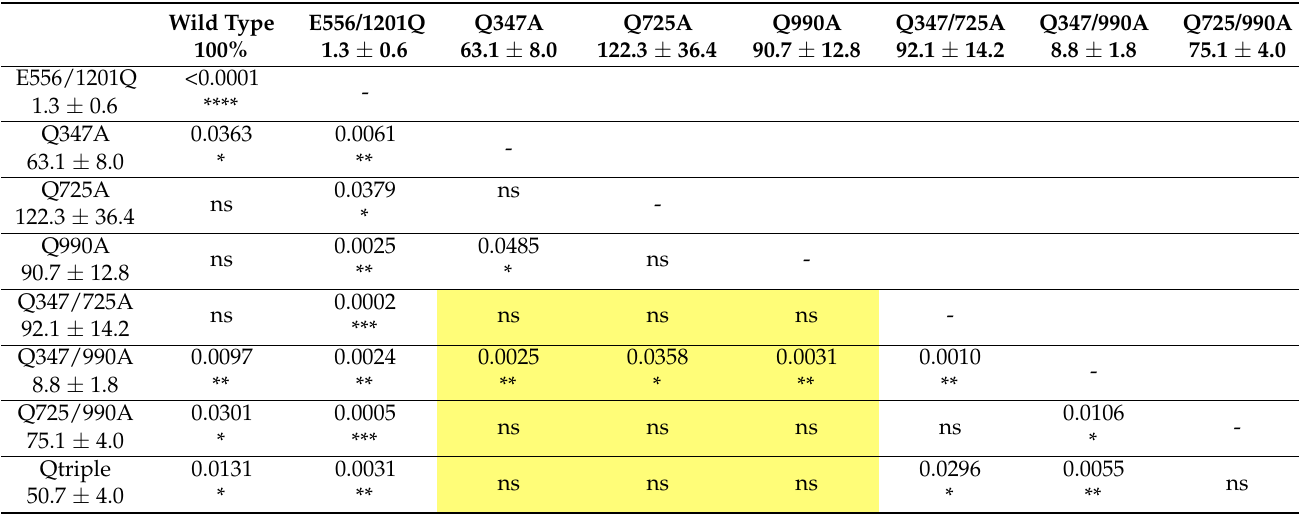
Table A1. Functionality of mutants for the transport of Calcein-AM normalized to the wild-type transporter and pairwise statistical comparison of the raw data.